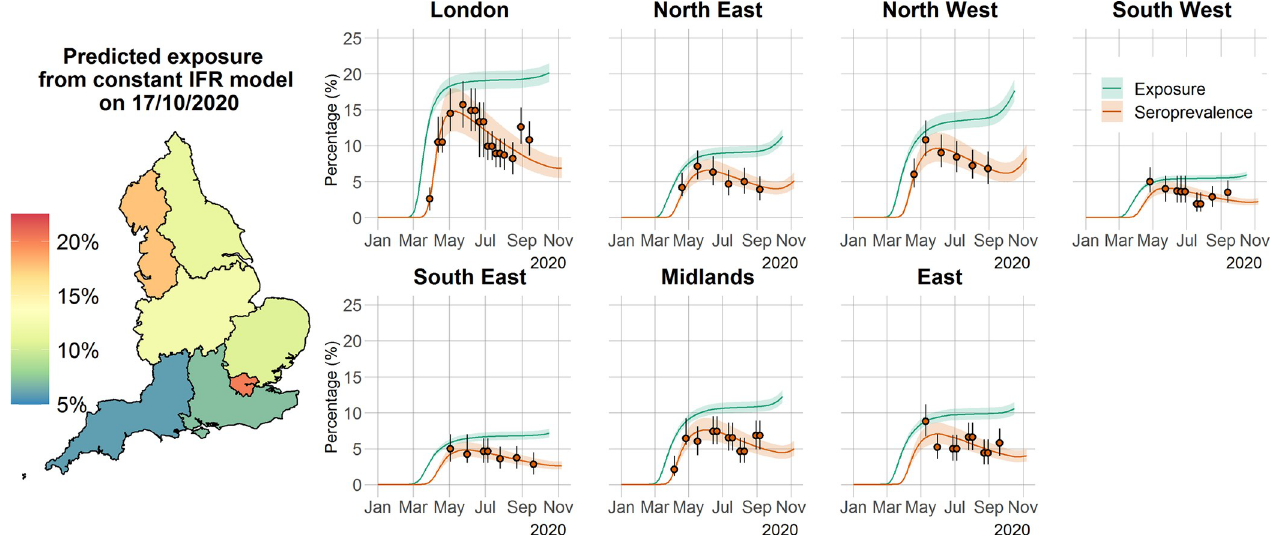
Fig 2. Time course of the SARS-CoV-2 pandemic up to 7 November 2020 for the seven regions in England in the constant IFR model. The solid orange circles and black error bars in each regional panel represent the observed seroprevalence data and their credible intervals, respectively, after adjusting for the sensitivity and specificity of the antibody test. The green and orange lines show the model predictions of median exposure and seroprevalence, respectively, while the shaded areas correspond to the 95% CrI. The regional predicted exposure levels (expressed as the proportion of the population that has been infected) as of 17 October 2020 are shown on the map of England. The map base layer was obtained from: https://opendata.arcgis.com/datasets/ 8d3a9e6e7bd445e2bdcc26cdf007eac7_4.geojson.